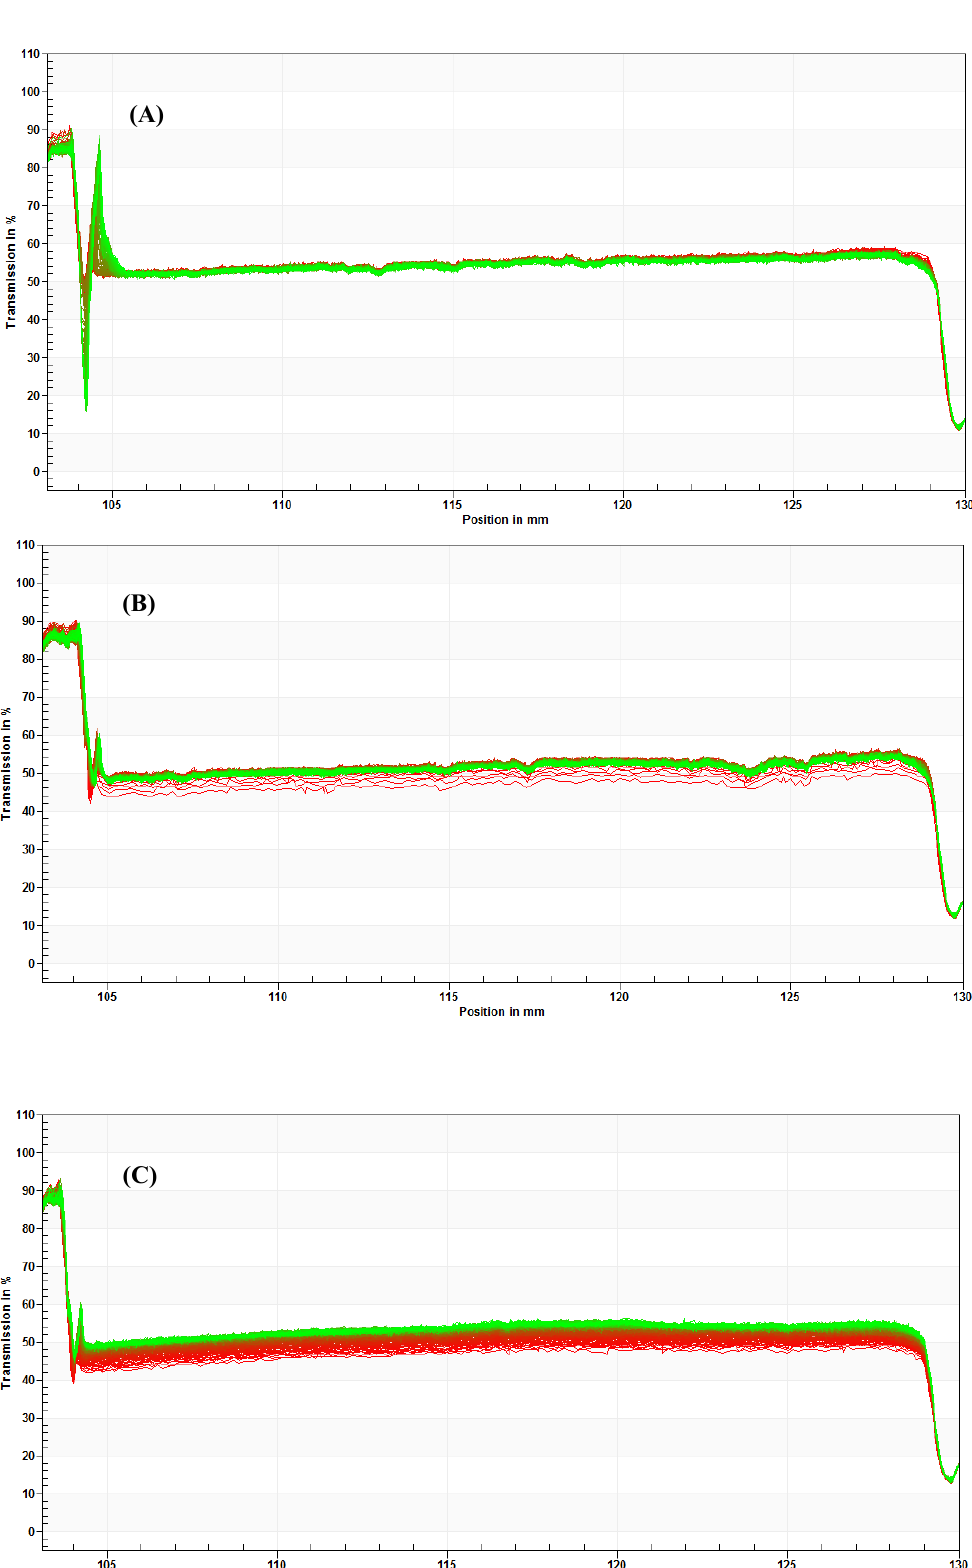
Figure 1. Evolution of the transmission profiles of the HA-based nanoemulsion containing P.